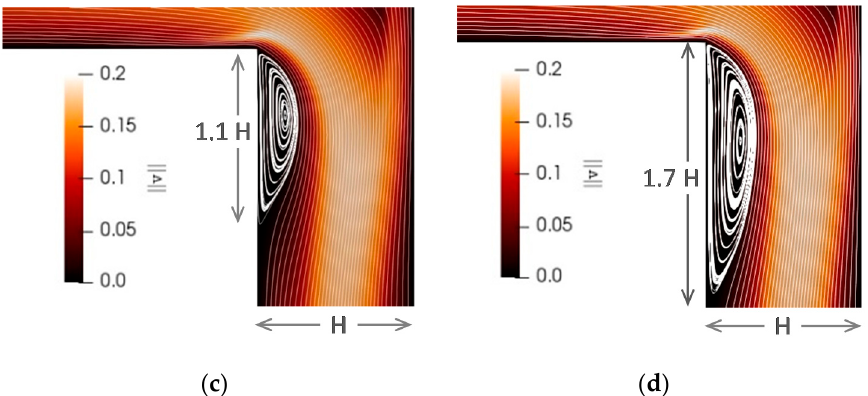
Figure 6. Downstream inertial vortices, Polymer Flow, Wi = 1.5 and β = 0.1: ( a ) Re = 50 (El = 0.03); ( b ) Re = 60 (El = 0.025); ( c ) Re = 75 (El = 0.02); ( d ) Re = 100 (El = 0.015).